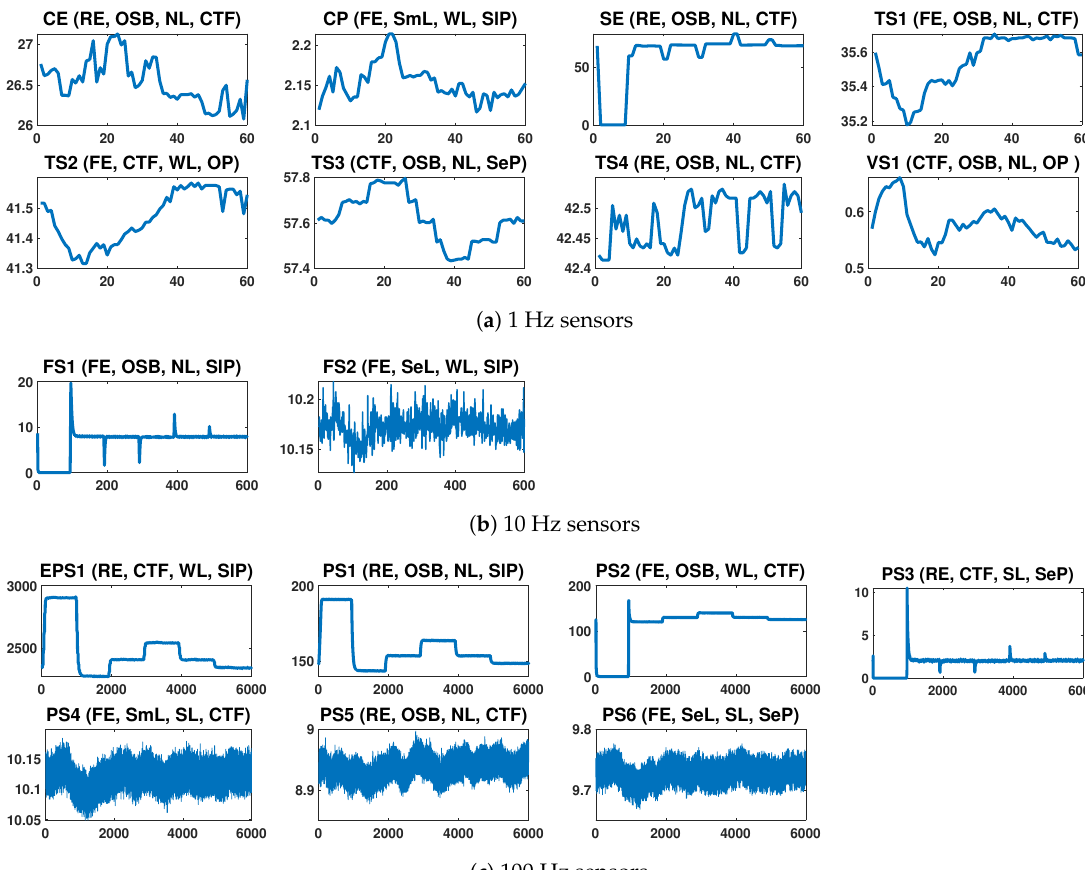
Figure 2. Signals of the 17 sensors of the test bench during selected load cycles. Each subfigure relates to a sensor signal showing the abbreviated sensor name followed by a short description of the degradation state of the four condition variables (cooler, valve, pump,